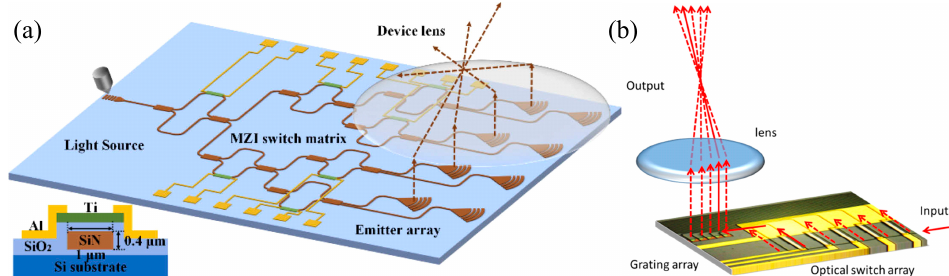
Figure 16. Potential alternatives of integrated OPAs. ( a ) A lens-based integrated 2D beam-steering device. Reprinted with permission from [157] © The Optical Society. ( b ) A beam switching optical scanner. Reprinted with permission from [158] © The Optical Society.